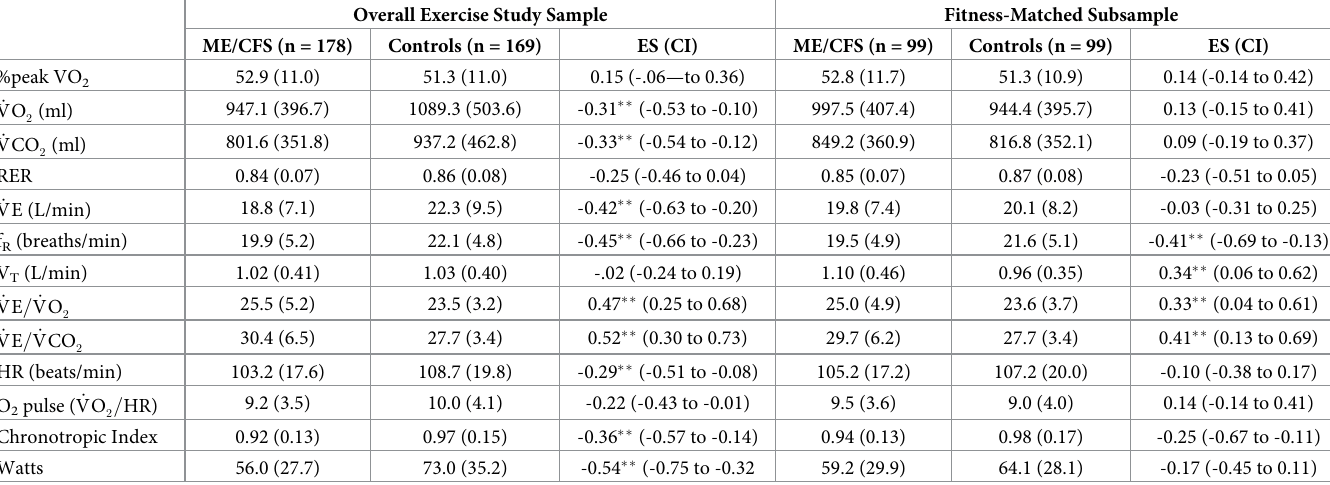
Table 2. Cardiopulmonary responses at the gas exchange threshold during exercise testing in ME/CFS patients and controls. Overall Exercise Study Sample Fitness-Matched Subsample